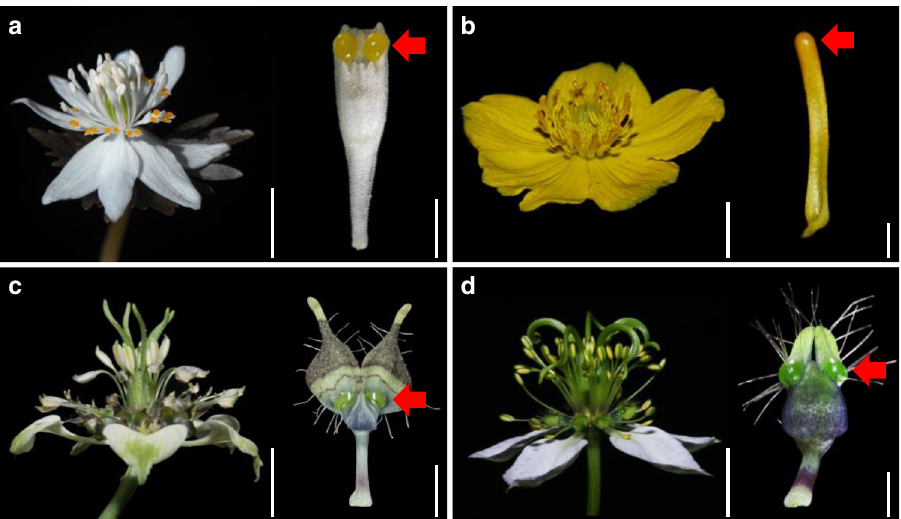
Fig. 1 Flowers and their pseudonectary-bearing petals in representative species of the Ranunculaceae. a Eranthis stellata . b Trollius buddae . c Nigella arvensis ssp. arvensis . d N. damascena . Red arrows point to the pseudonectaries. Scale bars at the right side of fl owers: 1 cm; scale bars at the right side of petals: 1